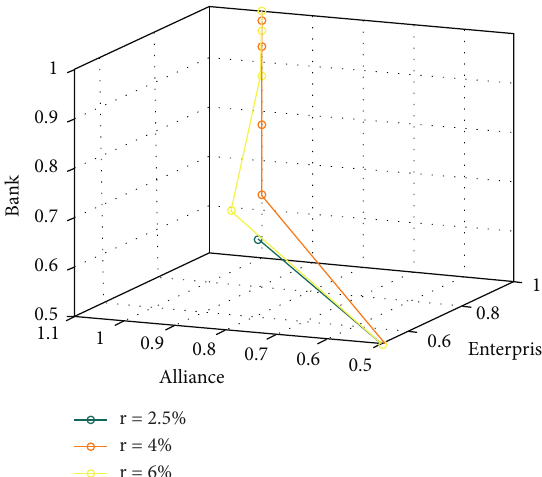
Figure 2: Three-party evolutionary game trajectory under different loan interest rates.